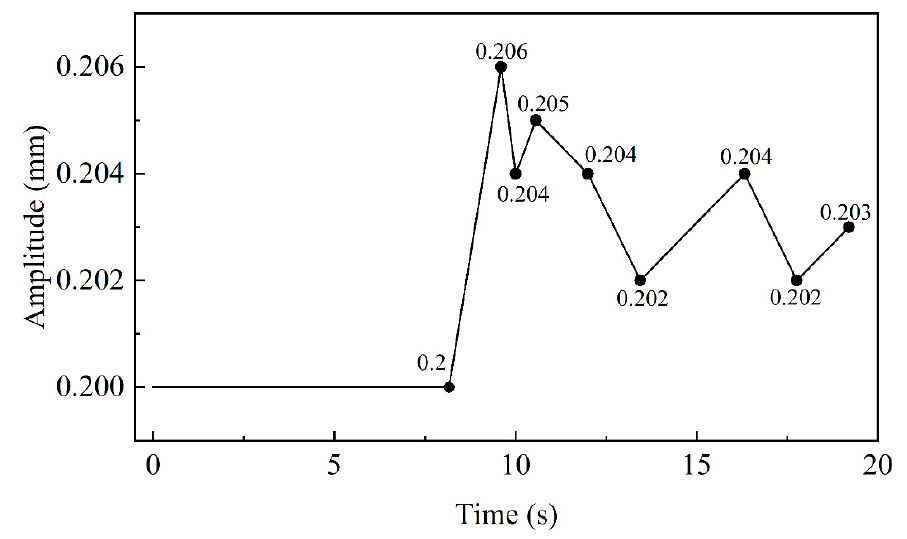
Figure 8. The amplitude-straightening time profiles of interface.